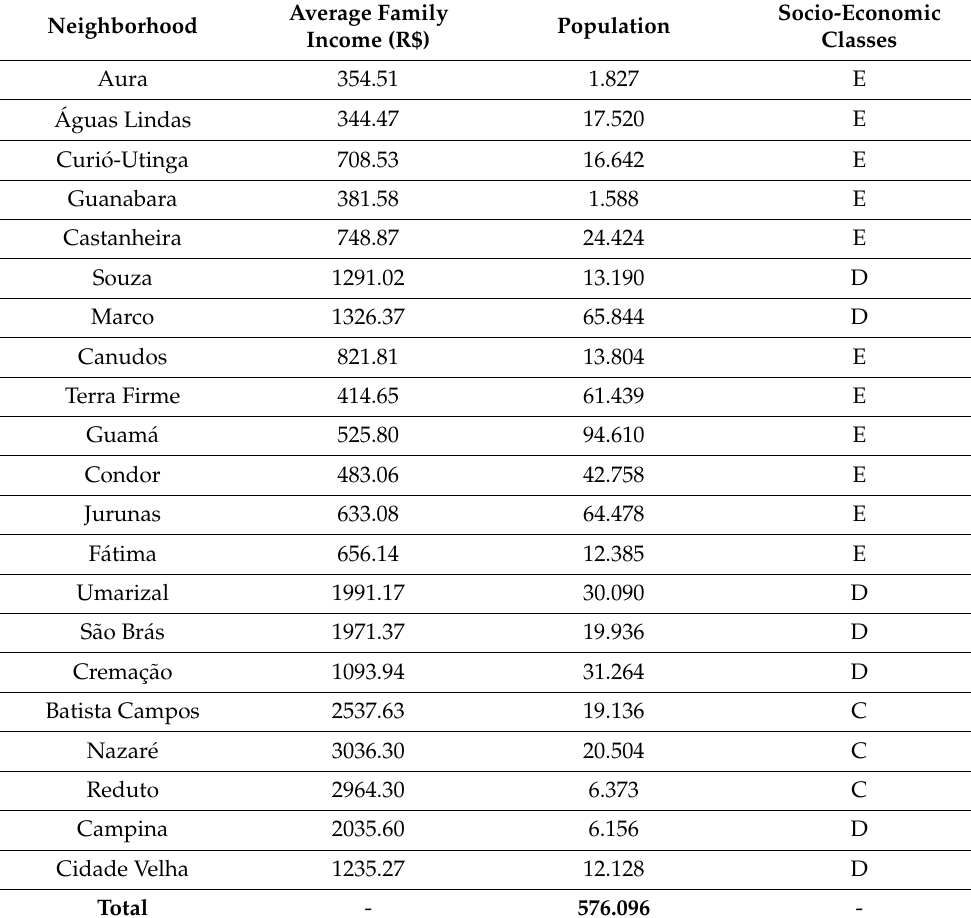
Table 2. Socio-economic classification, population, and average family income in reais (R$) of all the neighborhoods in the municipality of Bel é m-Par á -Brazil